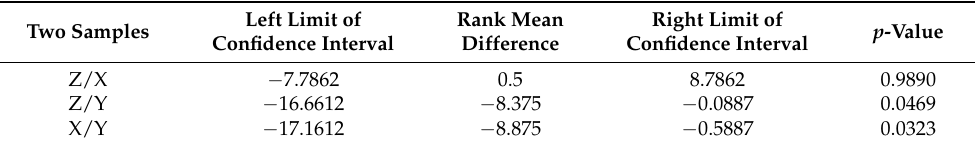
Table 10. The results of the multiple comparison test.